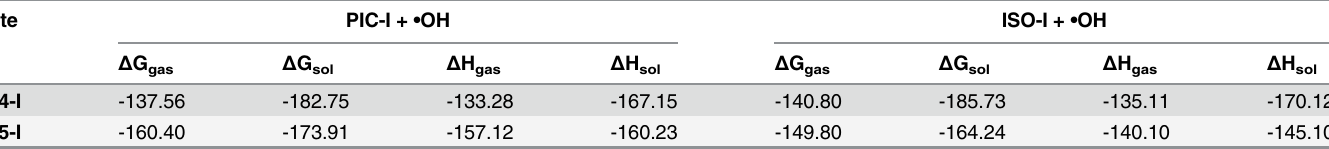
Table 7. The reaction Gibbs energies and reaction energies at 298K for reactions of PIC-I and ISO-I with (cid:129) OH in the gas phase and water (in kJ/ mol). site